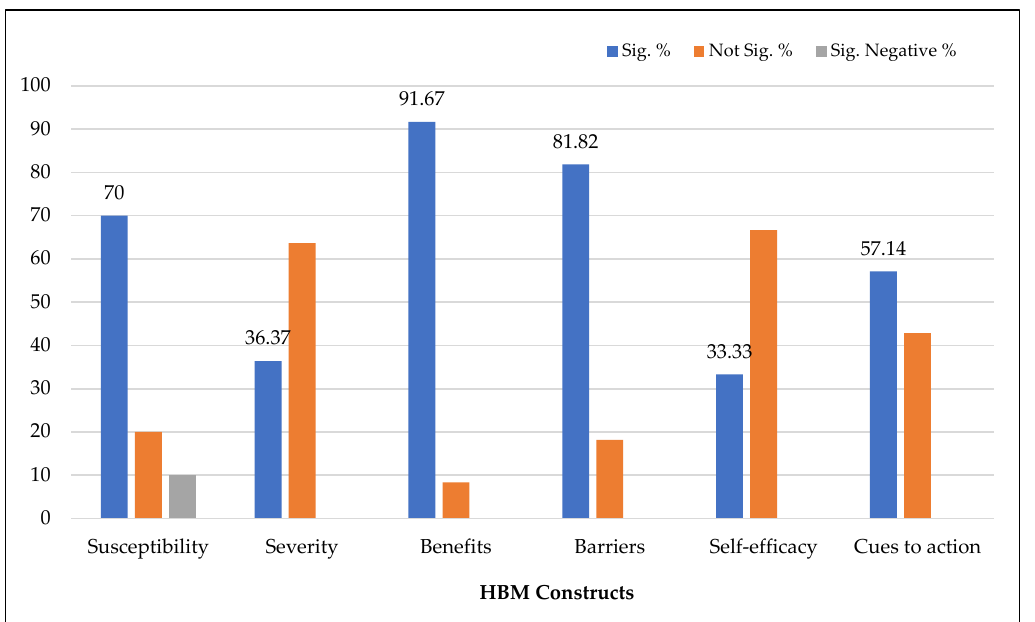
Figure 4. Health belief model constructs predicting booster vaccination intention.